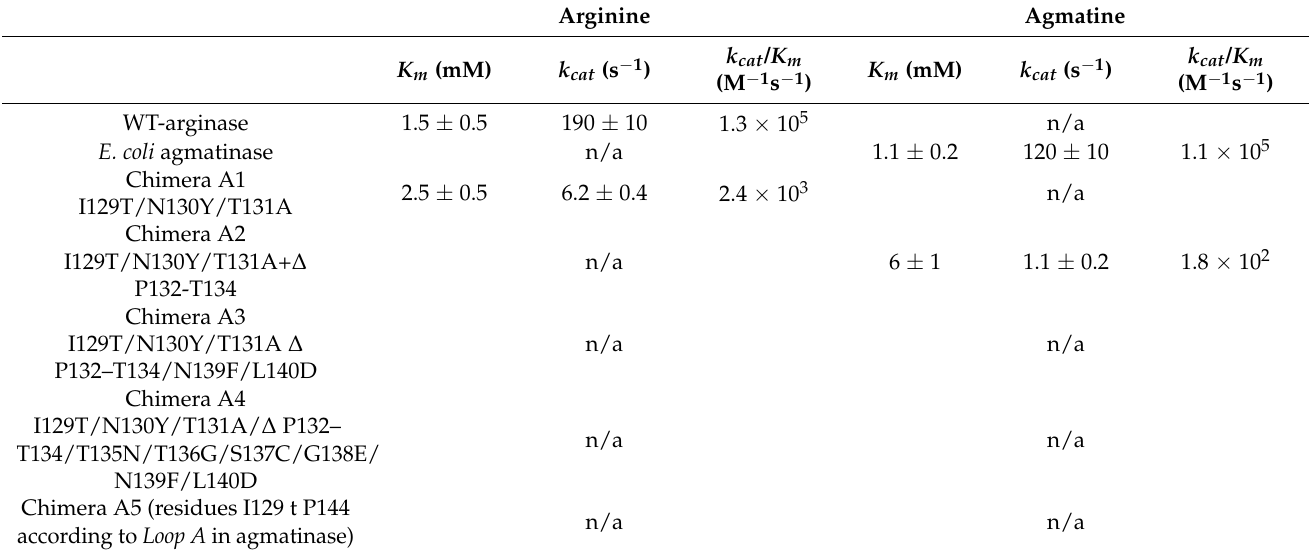
Table 2. Kinetic properties of the wild-type human arginase type I and chimeric species of loop A